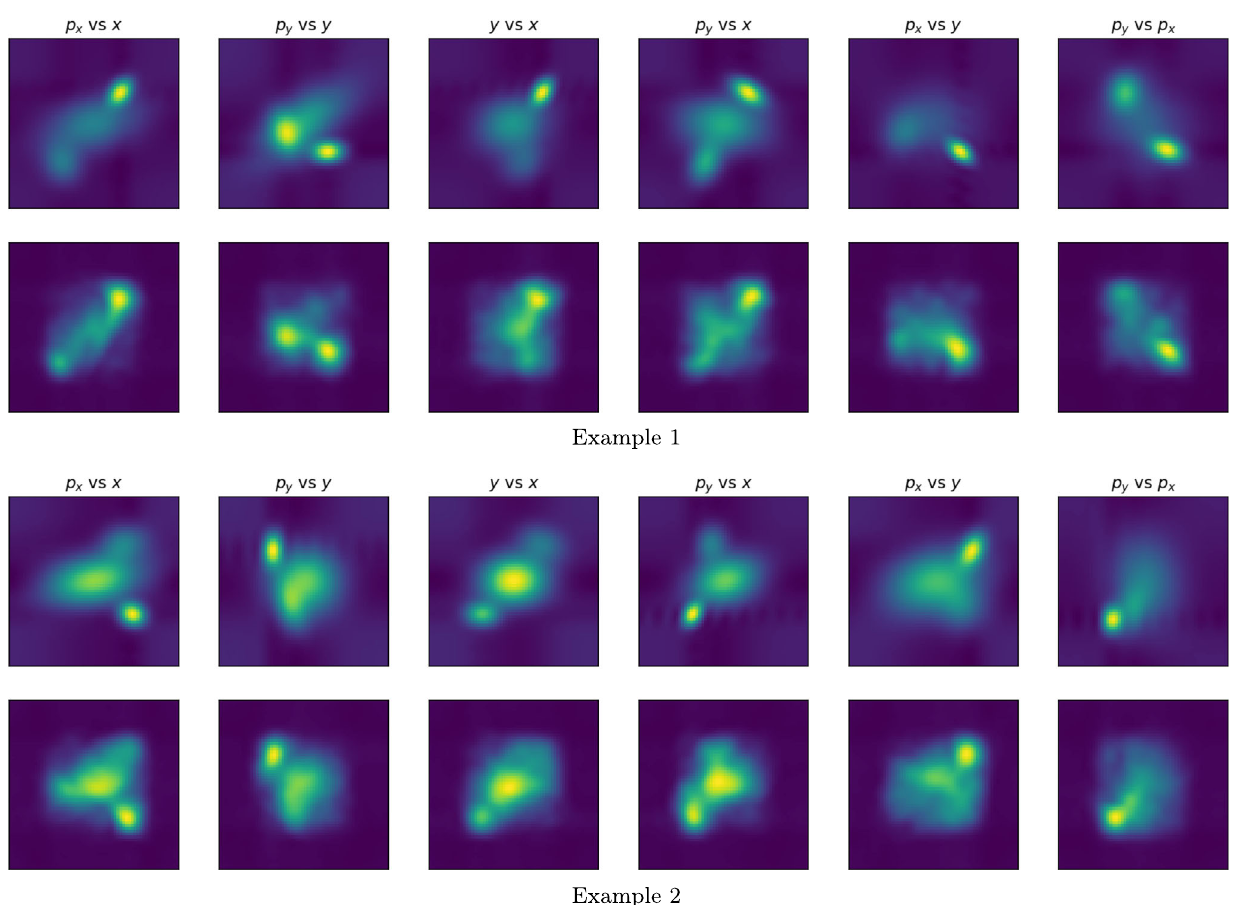
FIG. 8. Examples of reconstruction of charge density in 4D phase space using a neural network. Two different cases are shown, selected from the set of training data but reserved from (i.e., not used during) the training process. In each example, plots in the top row show different projections of the original phase space distribution from which the sinograms (projections onto x - y coordinate space following phase space rotations corresponding to steps in a quadrupole scan) are constructed. Plots in the bottom row show the corresponding projections from the 4D phase space reconstructed from the sinograms using the neural